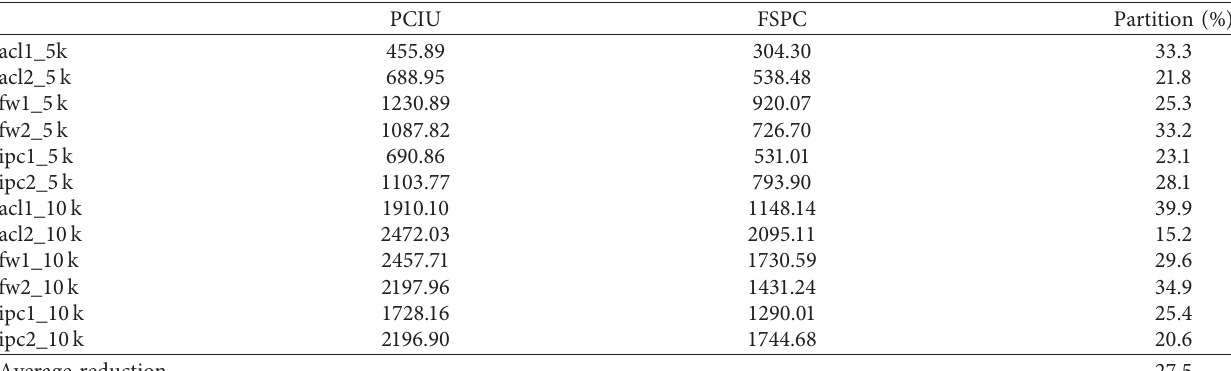
Table 5: Memory consumption for different rule sets with different sizes (kB).